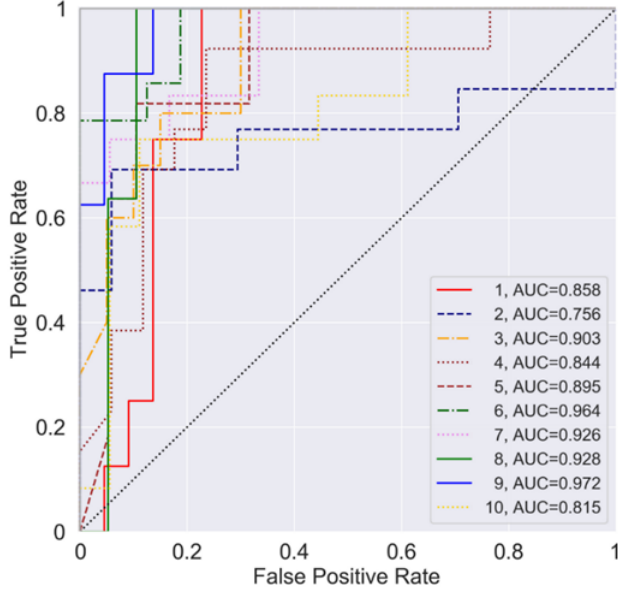
Figure 1. ROC curves and AUC values for MLPC models.